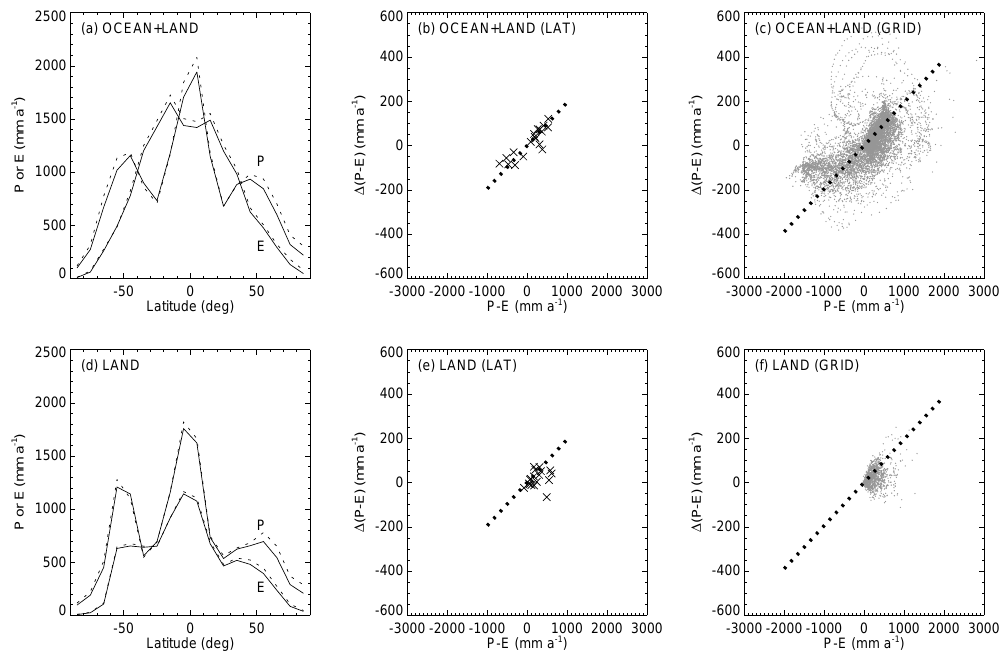
Fig. 1. Annual average P and E over the (top panels) globe (land plus ocean) and over (bottom panels) land. (a) Latitudinal distribution of P , E at the end of the 20th (1970–1999, 20C3M) (full) and 21st (2070–2099, A1B) (dotted) centuries. (b) 1 ( P − E ) versus P − E averaged over 10 ◦ latitudinal zones. (c) 1 ( P − E ) versus P − E at individual grid boxes. (d) , (e) , (f) Equivalent plots restricted to the land component. Dotted line (b) , (c) , (e) , (f) highlights the Held and Soden (2006) prediction ( 1 ( P − E )=0.07K − 1 × 2.8K × ( P − E )=0.20 × ( P − E